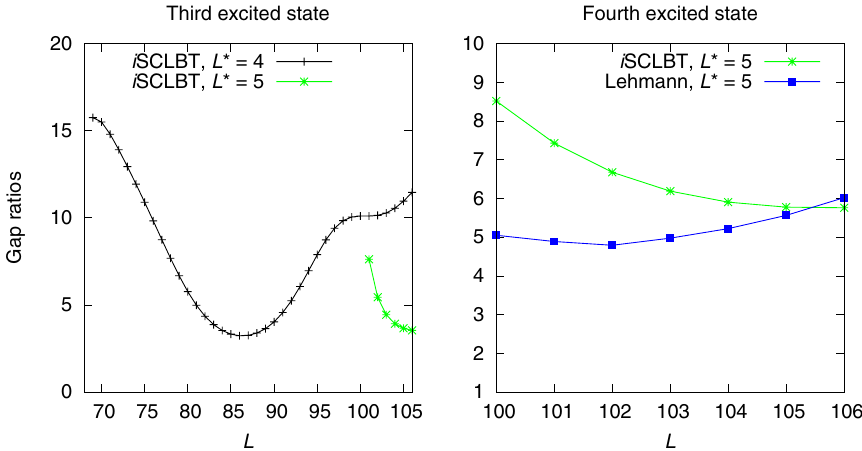
Figure 6. Results for the Hubbard model for the third and fourth excited states. Left panel: comparison of third excited state lower bound gap ratios calculated by the i SCLBT method. The gray and green lines indicate results at L ∗ = 4 and L ∗ = 5 , respectively. In this case the Lehmann results were of very low quality and thus, they are not included in the figure. Right panel: fourth excited state lower bound gap ratios for the i SCLBT (green line) and Lehmann (blue line) methods at L ∗ = 5 .